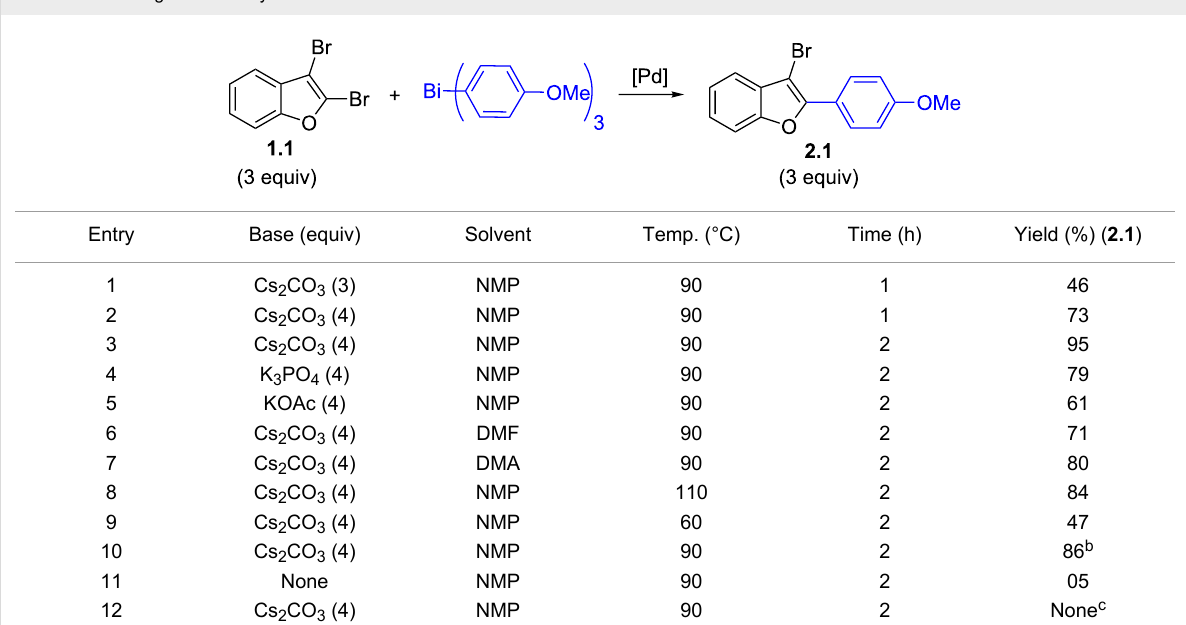
Table 1: Screening for mono-arylation.